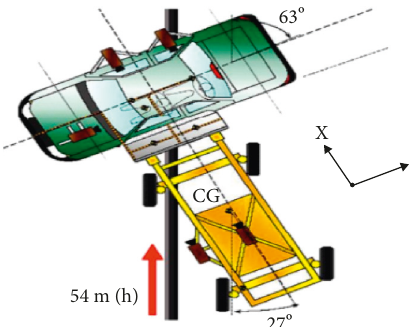
Figure 2: A FMVSS side impact test.